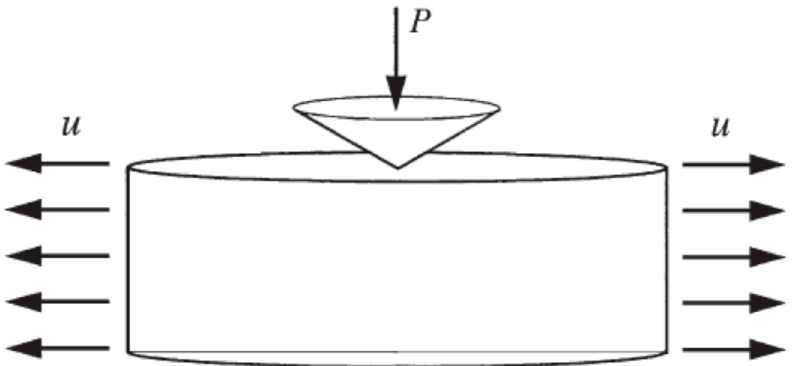
Figure 4. Schematic of the pre-indentation loading. u is the prescribed radial displacement at the outer surface generating applied (residual) stresses.